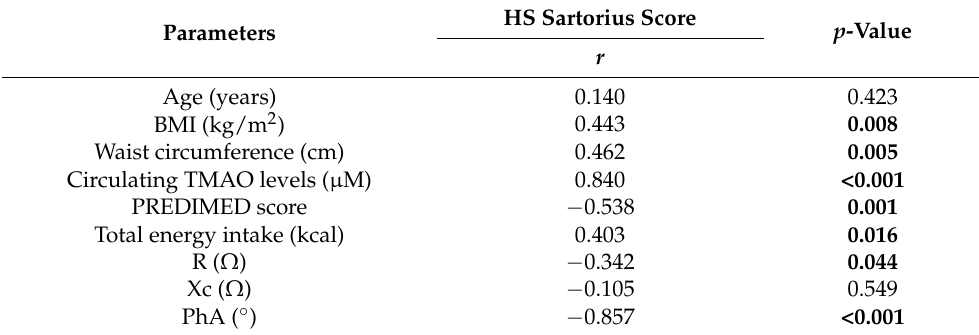
Table 3. Correlations between the clinical severity of HS with demographic characteristics, anthropo- metric measurements, nutritional assessments, and BIA parameters in patients with HS.